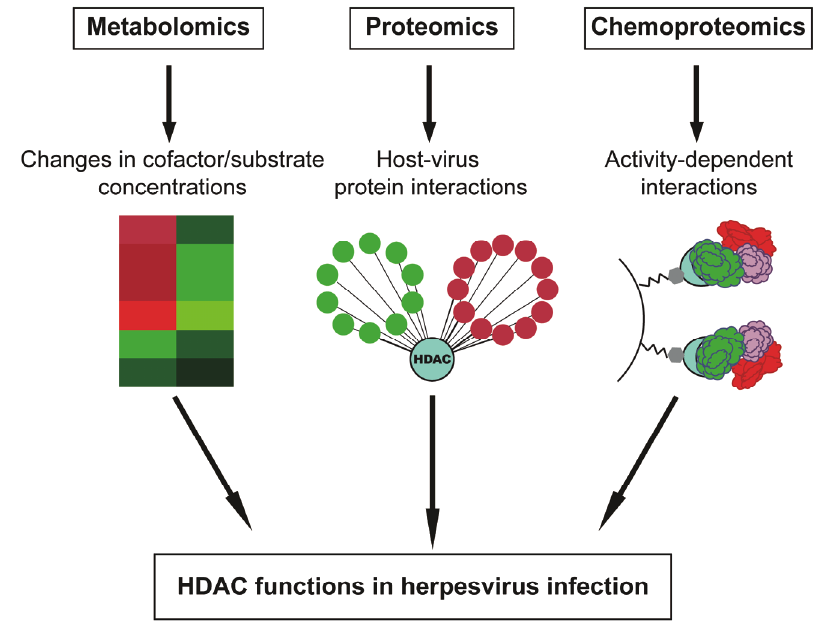
Figure 3. Assessing HDAC functions during infection through integrative omic